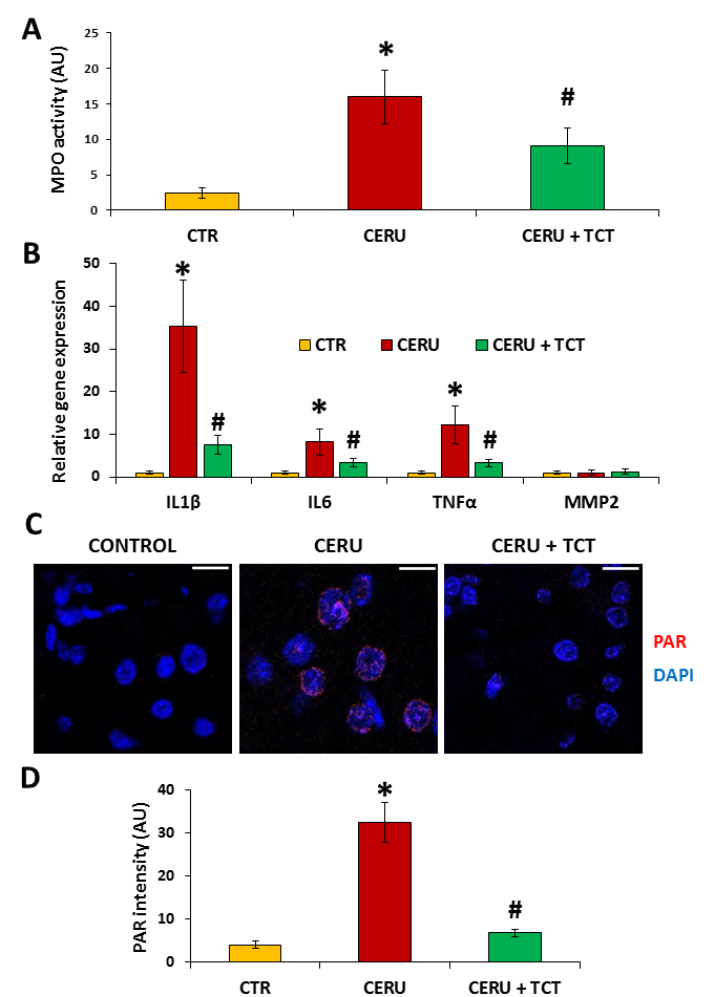
Figure 6. Tricetin inhibits inflammatory cell migration, PAR synthesis, and expression of inflamma- tory mediators in acute pancreatitis. Tricetin (TCT) treatment (2 × 10 mg/kg BW i.p.) suppressed neutrophil infiltration in the pancreas, as indicated by the decreased MPO level in the cerulein- induced acute pancreatitis model ( A ). TCT was effective in reducing IL1 β , IL6, and TNF α expression, as indicated by the RT-qPCR assay data ( B ). Representative pictures of PAR immunofluorescent staining of pancreas sections are shown ( C ). The extent of PARylation was quantified by ImageJ software ( D ). TCT treatment (2 × 10 mg/kg BW i.p.) decreased PARylation in the cerulein-induced acute pancreatitis model (scale bar 20 μ m) ( C , D ). Error bars represent the SD of six mice. Statistical analysis was performed with one-way ANOVA test followed by Tukey’s post hoc test. Stars (*) indicate significant ( p < 0.05) differences between cerulein-treated and control groups. Hashtags (#) indicate significantly ( p < 0.05) reduced scores in the TCT group versus the cerulein-treated group.